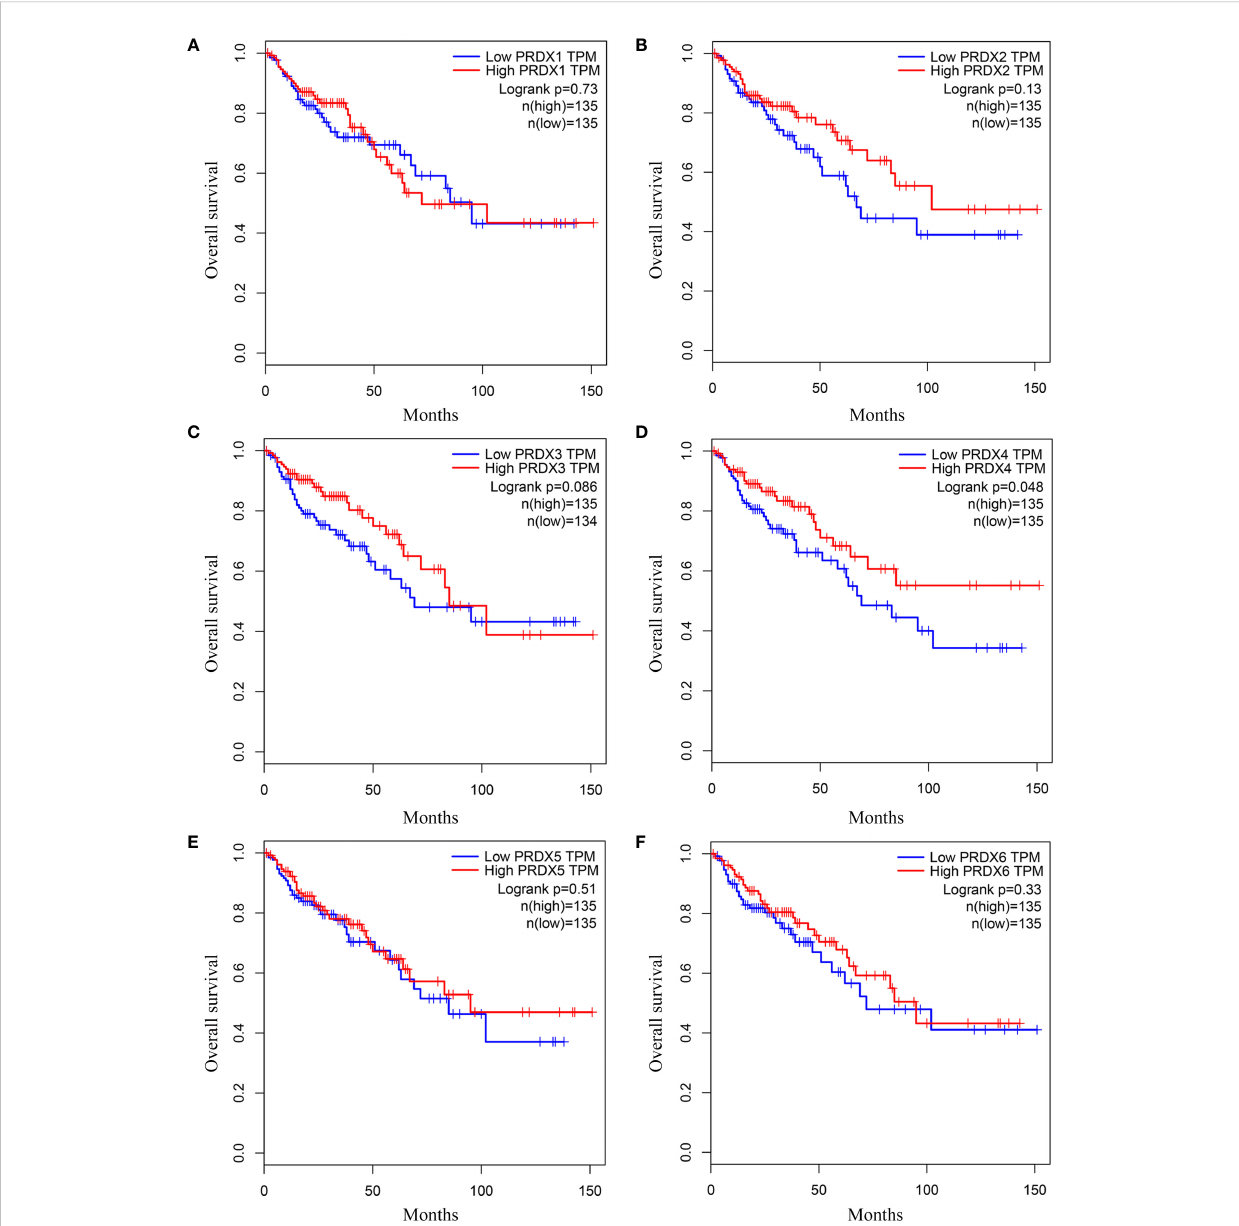
FIGURE 6 (A-F) The OS curves of PRDXs in COAD (GEPIA). (D) Only COAD patients with low expression of PRDX4 were signi fi cantly associated with shorter OS ( P < 0.05). OS, overall survival; COAD, colon